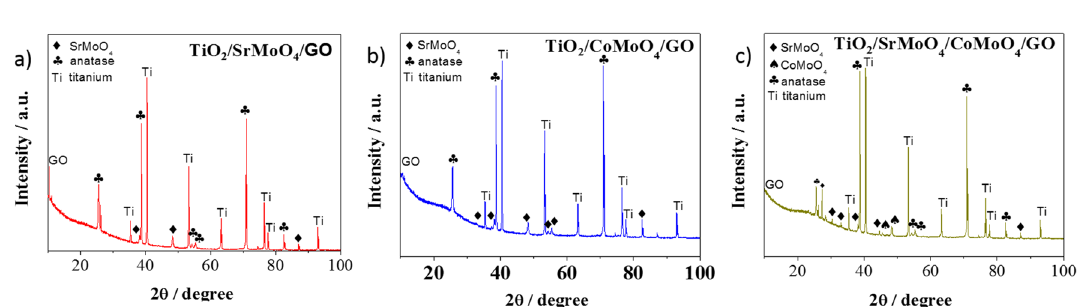
Figure 3. X-ray diffraction spectra of samples: ( a ) TiO 2 /SrMoO 4 , ( b ) TiO 2 /CoMoO 4 , ( c ) TiO 2 /SrMoO 4 / CoMoO 4 .